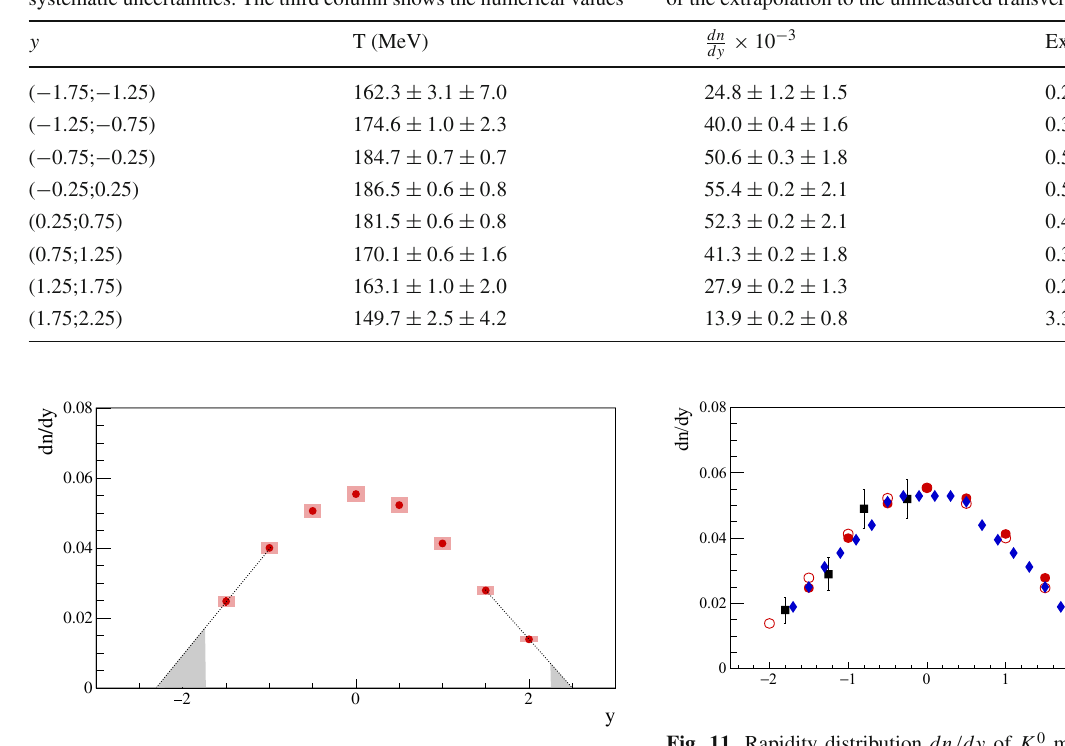
Fig. 10 Rapidity distribution dn / dy obtained by p T -integration. Sta- tistical uncertainties are shown by vertical bars (often smaller than the marker size), while a red shaded boxes indicates systematic uncertain- ties. The black dotted lines show the connection line between the last two points on both sides, and the grey areas are the contributions of the extrapolation to the mean multiplicity of K 0 data are listed in Table 3